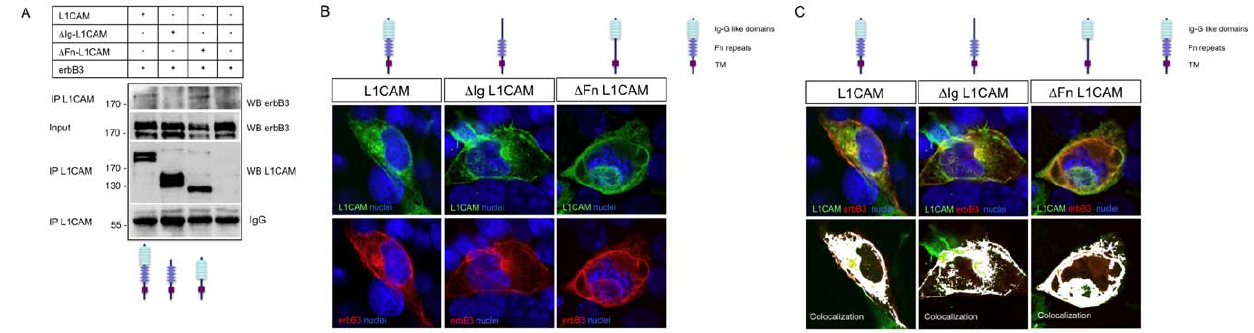
Figure 2. The Ig-like domains but not the fibronectin repeats of L1CAM mediate the physical interaction with erbB receptors. a) Ablation of Ig-like domains abrogates L1CAM interaction with erbB3: HEK293 cells were transfected with pcDNA3-erbB3 and the different truncated forms of L1CAM. Cell extracts were immunoprecipitated with anti-L1CAM antibody and blotted against erbB3. As is shown, erbB3 was pulled down when co-expressed with the full length and D Fn-L1CAM constructs, but not when was co-expressed with the D Ig-L1CAM construct. As expected, anti- L1CAM antibody does not immunoprecipate cells transfected with pcDNA3-erbB3 exclusively. Input lanes demonstrate the expression of erbB3 in the extracts. An aliquot of the immunoprecipitate was probed with anti-L1CAM to verify the adequate immunoprecipitation of the truncated proteins. IgG bands show that a similar amount of immunoprecipitate was loaded. This experiment was repeated three times. A representative experiment is shown. b) To rule out sorting problems that could explain the absence of co-IP, L1CAM and deleted constructs were co-transfected with erbB3 in COS-7 cells. As is shown, the distribution of L1CAM, D Ig-L1CAM and D Fn-L1CAM is similar when transfected into HEK293 cells, being detectable in the plasma membrane. c) The co-localization of the deleted constructs and full length L1CAM with erbB3 was nearly complete, ruling out sorting defects for the mutant proteins. L1CAM was detected with the anti-L1CAM monoclonal antibody (green) and erbB3 with a polyclonal antibody (red). Nuclei were counterstained with the Hoechst stain (blue). Co-localization (white) was revealed with the ImageJ software and the Co-localization Finder plugin.